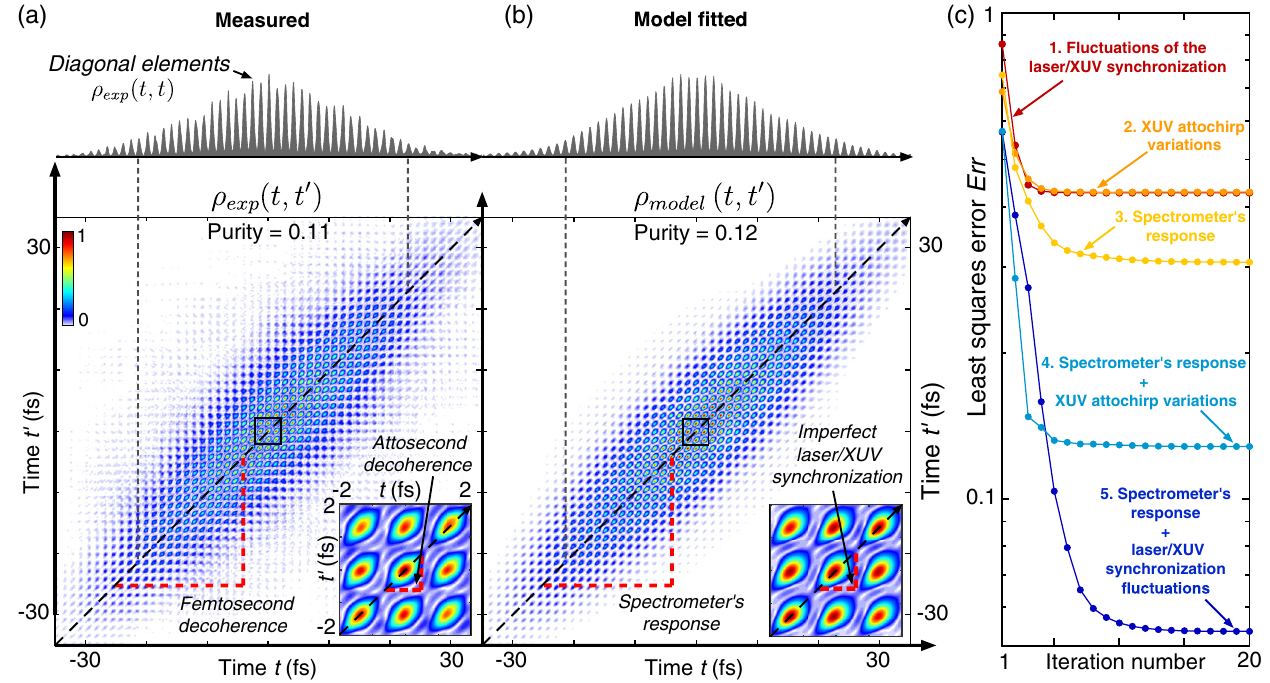
ϵ ; ϵ 0 Þ provides the experimental density matrix in the time FIG. 3. Comparison to decoherence models. (a) Fourier transforming ρ exp ð t; t 0 Þ ; only the modulus is shown. Inset: Enlargement of the area delimited by the black square in the main panel. Its domain ρ exp ð diagonal elements (upper) give the time structure of the electron wave packet. Off-diagonal-element disappearance, also called decoherence, can be observed at the femtosecond and attosecond timescales as emphasized by the red dashed lines. (b) To identify the physical origin of decoherence, several density matrix models ρ are fitted onto ρ . The best agreement (shown here) is obtained model exp with model 5: The femtosecond decoherence comes from the limited spectrometer resolution, while the attosecond decoherence arises from fluctuations of the synchronization between the laser and XUV pulses in the spectrometer. (c) Evolution of the least-squares error 2 dtdt 0 with the number of iterations of the fitting algorithm for various decoherence ∬ j ρ − ρ exp model j